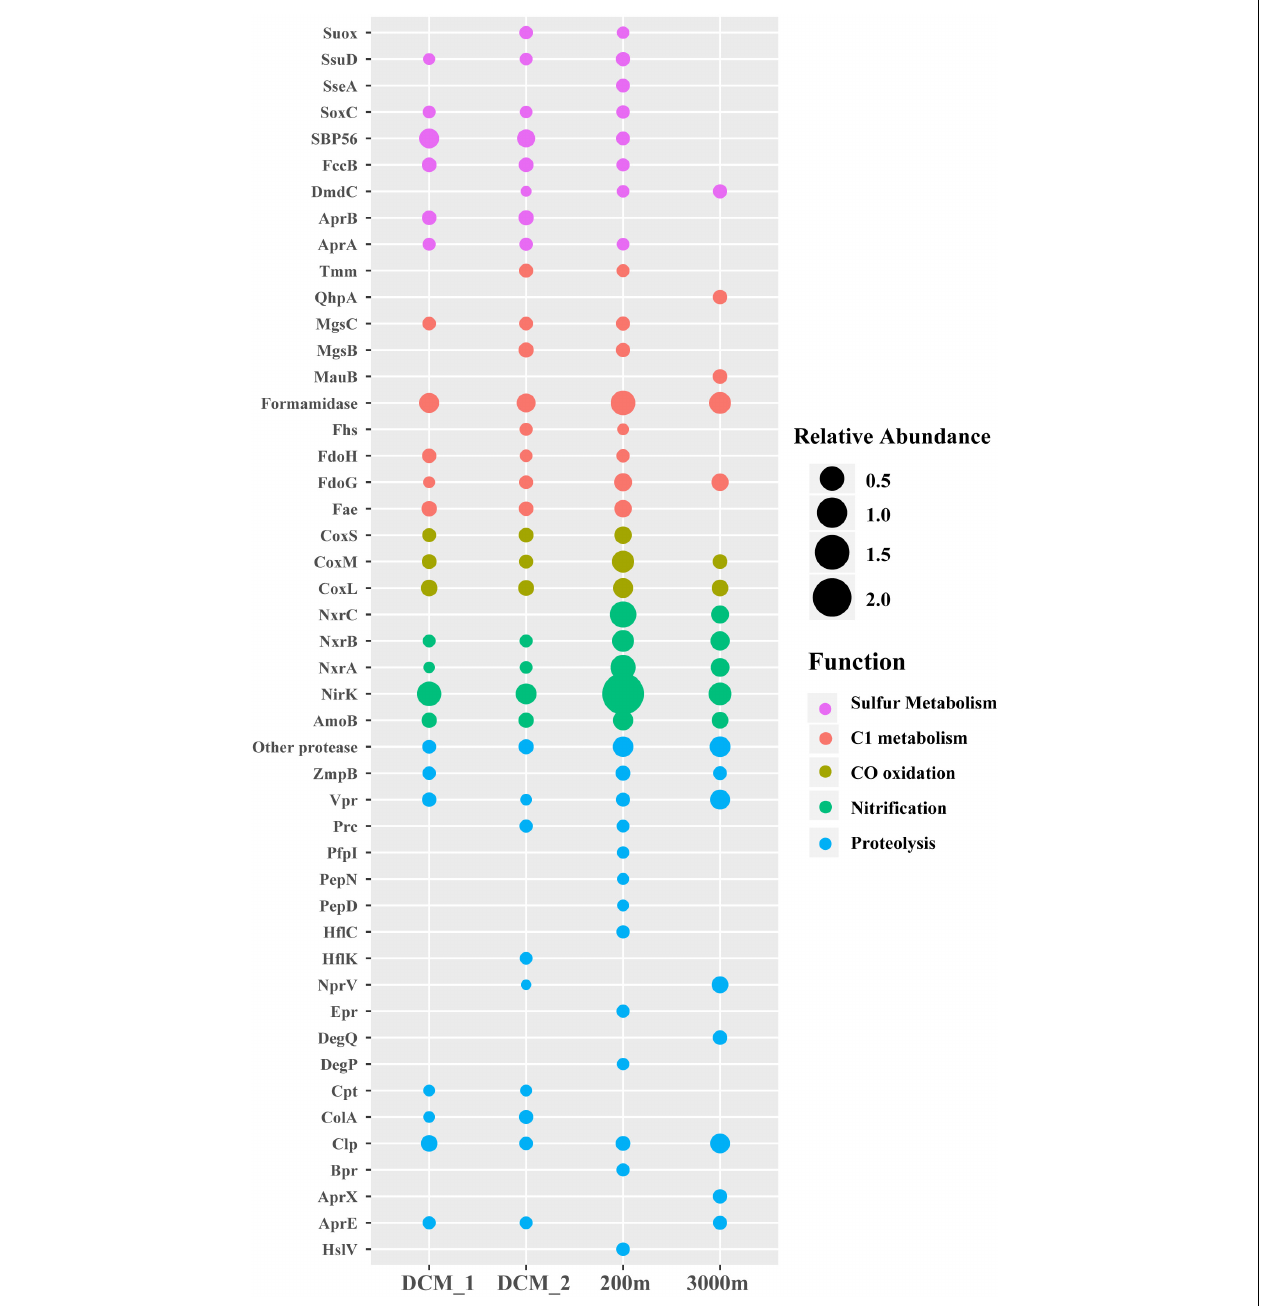
FIGURE 5 | Depth-variable pattern of selected exoproteins detected in the vertical exoproteomes in the SCS. Bubble size indicates the relative abundance of each protein. Suox, sulfite oxidase; SsuD, alkanesulfonate monooxygenase; SseA, thiosulfate/3-mercaptopyruvate sulfurtransferase; SoxC, sulfane dehydrogenase subunit SoxC; SBP56, 56-kDa selenium-binding protein; FccB, sulfide dehydrogenase; DmdC, 3-(methylthio) propanoyl-CoA dehydrogenase; AprA and AprB, adenylylsulfate reductase subunits A and B; Tmm, trimethylamine monooxygenase; QhpA, quinohemoprotein amine dehydrogenase; MgsB and MgsC, methylamine-glutamate N-methyltransferase subunits B and C; MauB, methylamine dehydrogenase heavy chain; Fhs, formate-tetrahydrofolate ligase; FdoH, formate dehydrogenase iron-sulfur subunit; FdoG, formate dehydrogenase major subunit; Fae, 5,6,7,8-tetrahydromethanopterin hydro-lyase; CoxL, CoxM, and CoxS, large, medium and small subunits of aerobic carbon-monoxide dehydrogenase; NxrA, NxrB, and NxrC, alpha, beta and gamma subunits of nitrite oxidoreductase; NirK, nitrite reductase (NO-forming); AmoB, ammonia monooxygenase subunit B; ZmpB, zinc metalloprotease ZmpB; Vpr, minor extracellular serine protease Vpr; Prc, carboxyl-terminal processing protease; PepN, aminopeptidase N; PfpI, protease I; PepD, putative serine protease PepD; HflK and HflC, membrane protease subunits HflK and HflC; NprV, vibriolysin; Epr, minor extracellular protease Epr; DegQ, serine protease DegQ; DegP, serine protease Do; Cpt, carboxypeptidase T; ColA, microbial collagenase; Clp, ATP-dependent Clp protease; Bpr, bacillopeptidase F; AprX, serine protease AprX; AprE, subtilisin; HslV, ATP-dependent HslUV protease, peptidase subunit HslV.